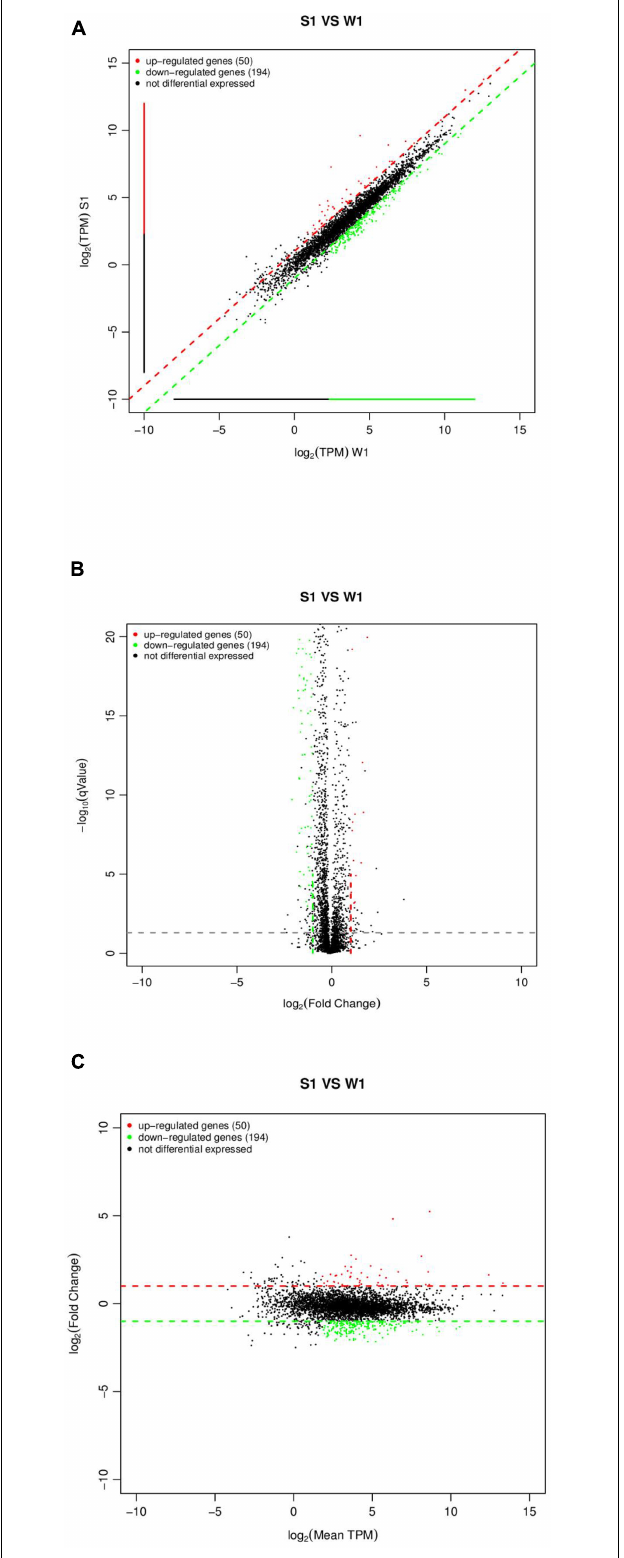
FIGURE 6 | Expression difference analysis for transcriptional profiles [ C. sakazakii (cid:49) sdiA mutant (S1) compared to WT (W1) strains]. (A) Comparison group expression difference scatter plot. MeanTPM: Expression amount of a group. The horizontal and vertical axes are, respectively, the log 2 (TPM) values of two groups of samples. Each point in the figure represents a gene, and the closer the point expression is to the origin the lower. The vertical sample is relative to the horizontal sample. (B) Comparison group expression difference volcano diagram. The horizontal axis represents the fold-change [log 2 (B/A)] value of gene expression difference between different groups of samples. The vertical axis represents gene expression pValue, the smaller the pValue, the greater the − log 10 (pValue), and the more significant the difference. (C) MA diagram of expression difference between groups was compared. The horizontal axis is the mean value of log 2 (TPM) of the two groups of samples {[log 2 (A) + log 2 (B)]/2}. The vertical axis is log 2 (Fold Change) [that is, log 2 (B/A)]